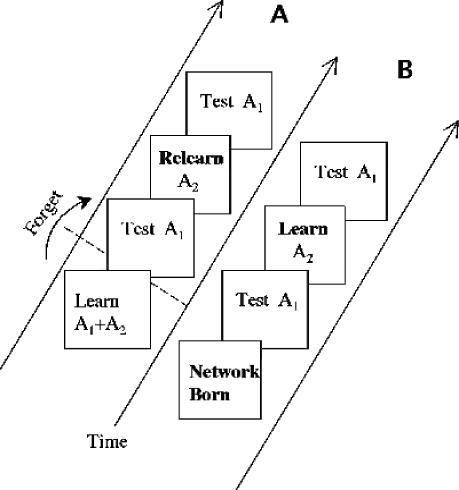
Free-Lunch Learning within and across Generations(A) FLL within the single lifetime of a neural network model. Two subsets of associations A
1 and A
2 are learned. After partial forgetting (see text), performance error on subset A
1 is measured. Subset A
2 is then relearned, and performance error on subset A
1 is measured again. If performance error on A
1 decreases as a result of learning A
2, then FLL has occurred.(B) FLL across generations. Using a genetic algorithm, a network is born with connections similar to those of the network in a after it has learned and then partially forgotten subsets A
1 and A
2. Consequently, innate performance error on A
1 is similar to that of the network in a after it has partially forgotten both subsets. After measuring performance error on A
1 at birth, subset A
2 is learned for the first time, and performance error on subset A
1 is measured again. After many generations, the innate connection values of each network ensure that if subset A
2 is learned for the first time, then this induces automatic learning of subset A
1.